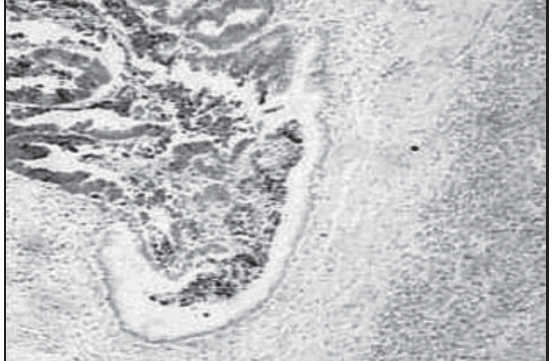
PASCHOAL, J. et al . Metástase hepática de adenocarcinoma colorretal com disseminação endobiliar: expressão das citoqueratinas 7, 19 e 20 (cid:127) J Bras Patol Med Lab (cid:127) v. 43 (cid:127) n. 1 (cid:127) p. 51-54 (cid:127) fevereiro